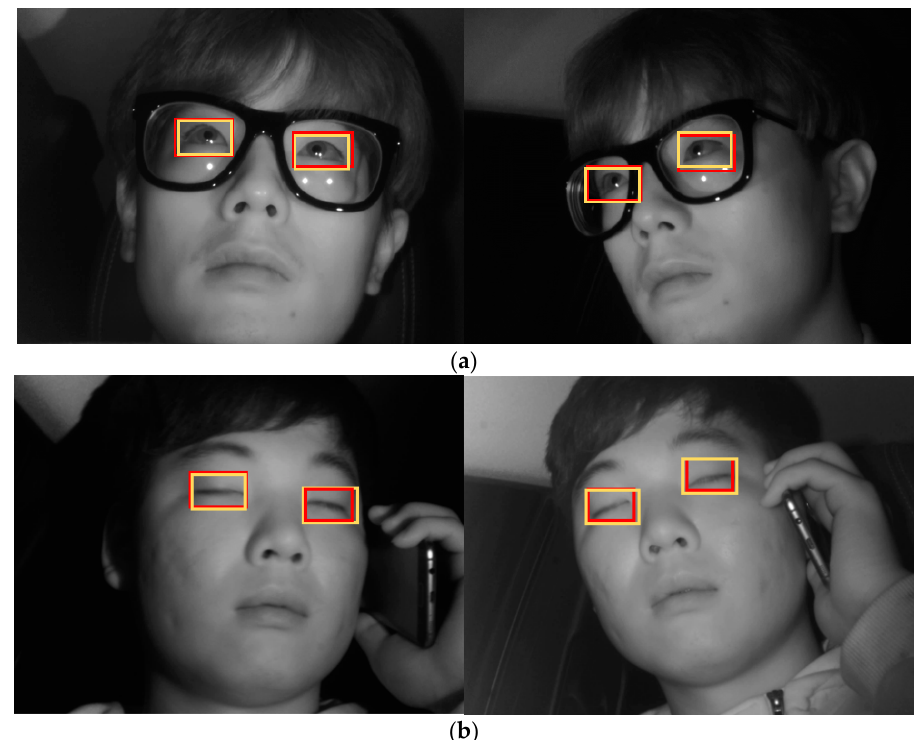
Figure 19. Examples of correctly detected driver’s eye obtained using the proposed method: ( a ) open eye; ( b ) closed eye. (Yellow and red rectangles show the ground-truth and detected boxes, respectively).